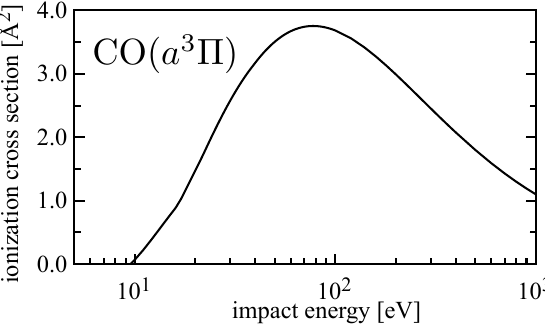
Figure 2. BEB cross sections for total ionization of CO ( a 3 Π ) metastable [29].